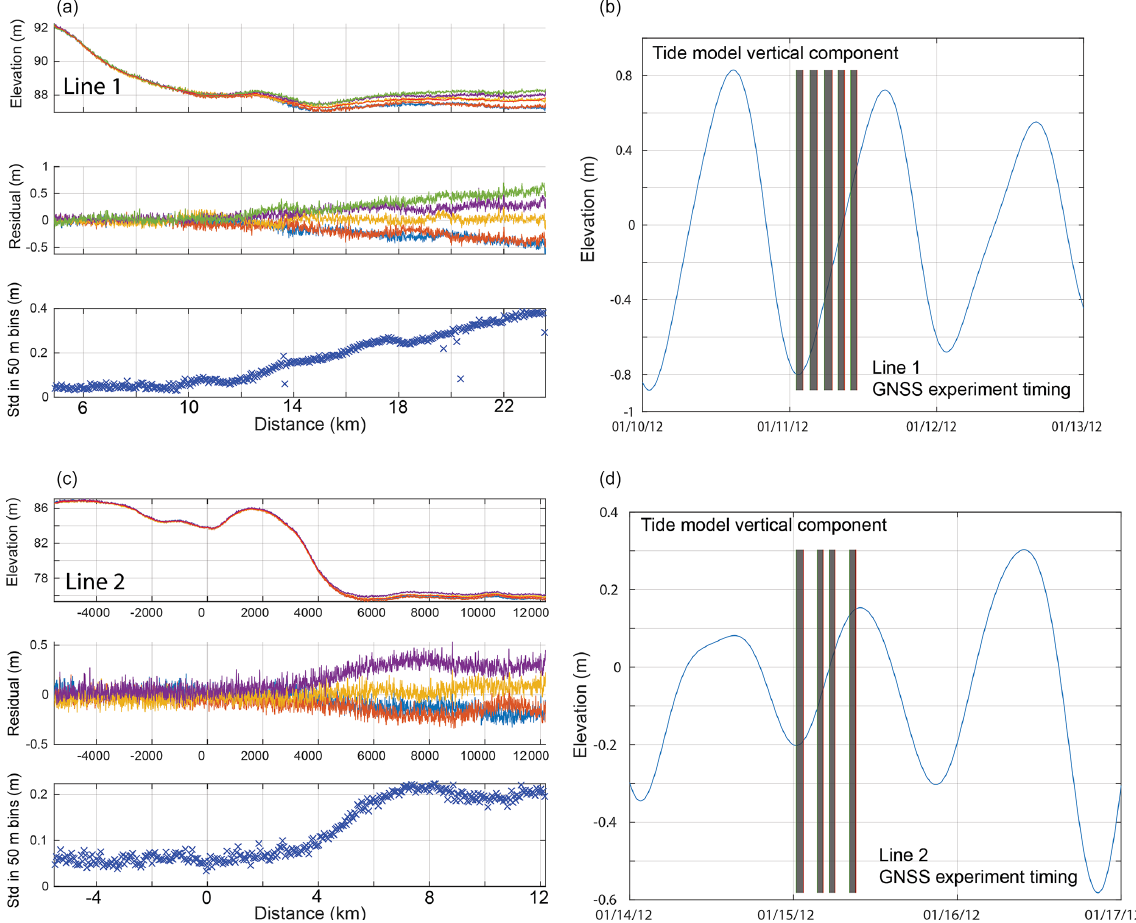
Figure 9. Repeat kinematic profiling along lines 1 (a, b) and 2 (c, d) . ( a and c ) The elevation (top), residual elevation after removal of a best-fitting spline (middle), and standard deviation of residual elevation in 50m spatial bins (bottom). ( b and d ) The timing of the GNSS profile data collection (vertical overlain on the vertical elevation anomaly of Erofeeva et al.